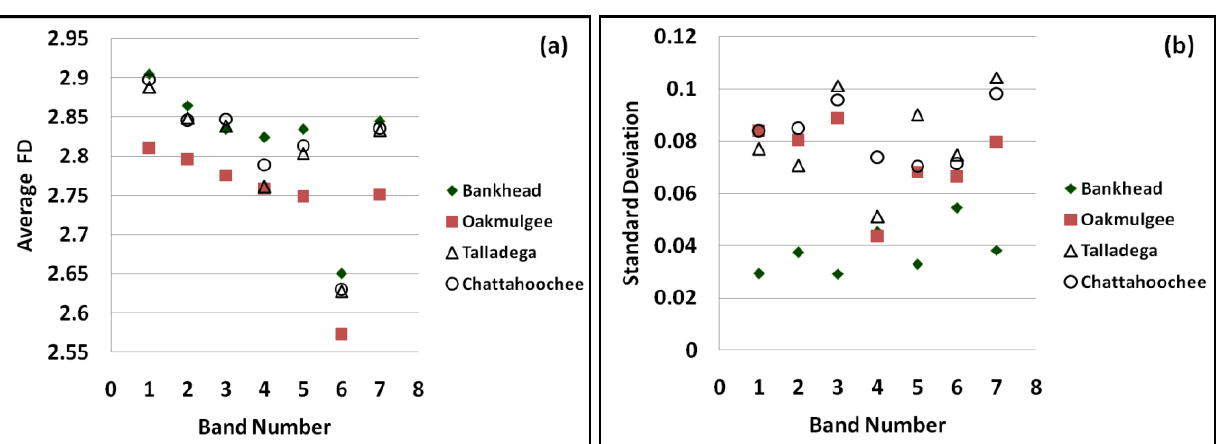
Figure 16. Descriptive statistics of fractal dimensions for all bands: (a) average (b) standard